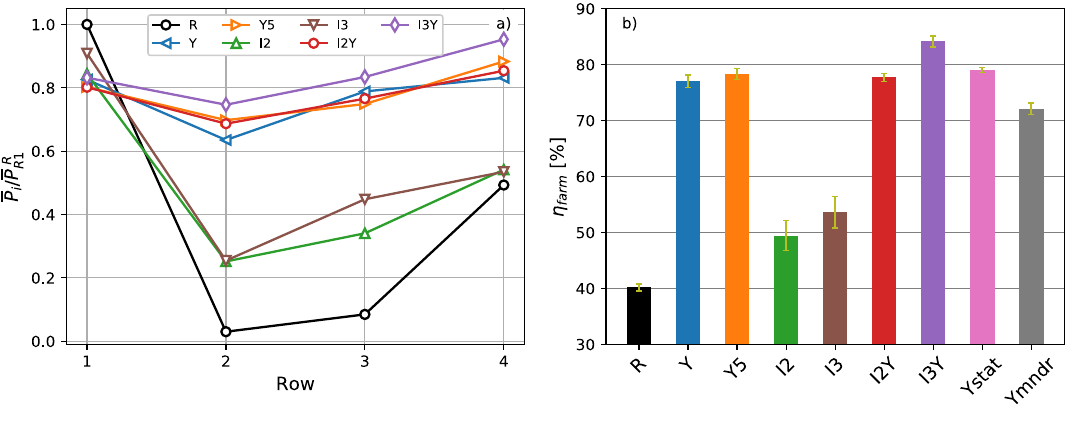
Figure 6. Wind-farm power extraction for reference case R, optimal control cases (Y, Y5, I2, I3, I2Y, and I3Y), and derived control cases (Ystat and Ymndr). ( a ) Row-averaged power, normalized by